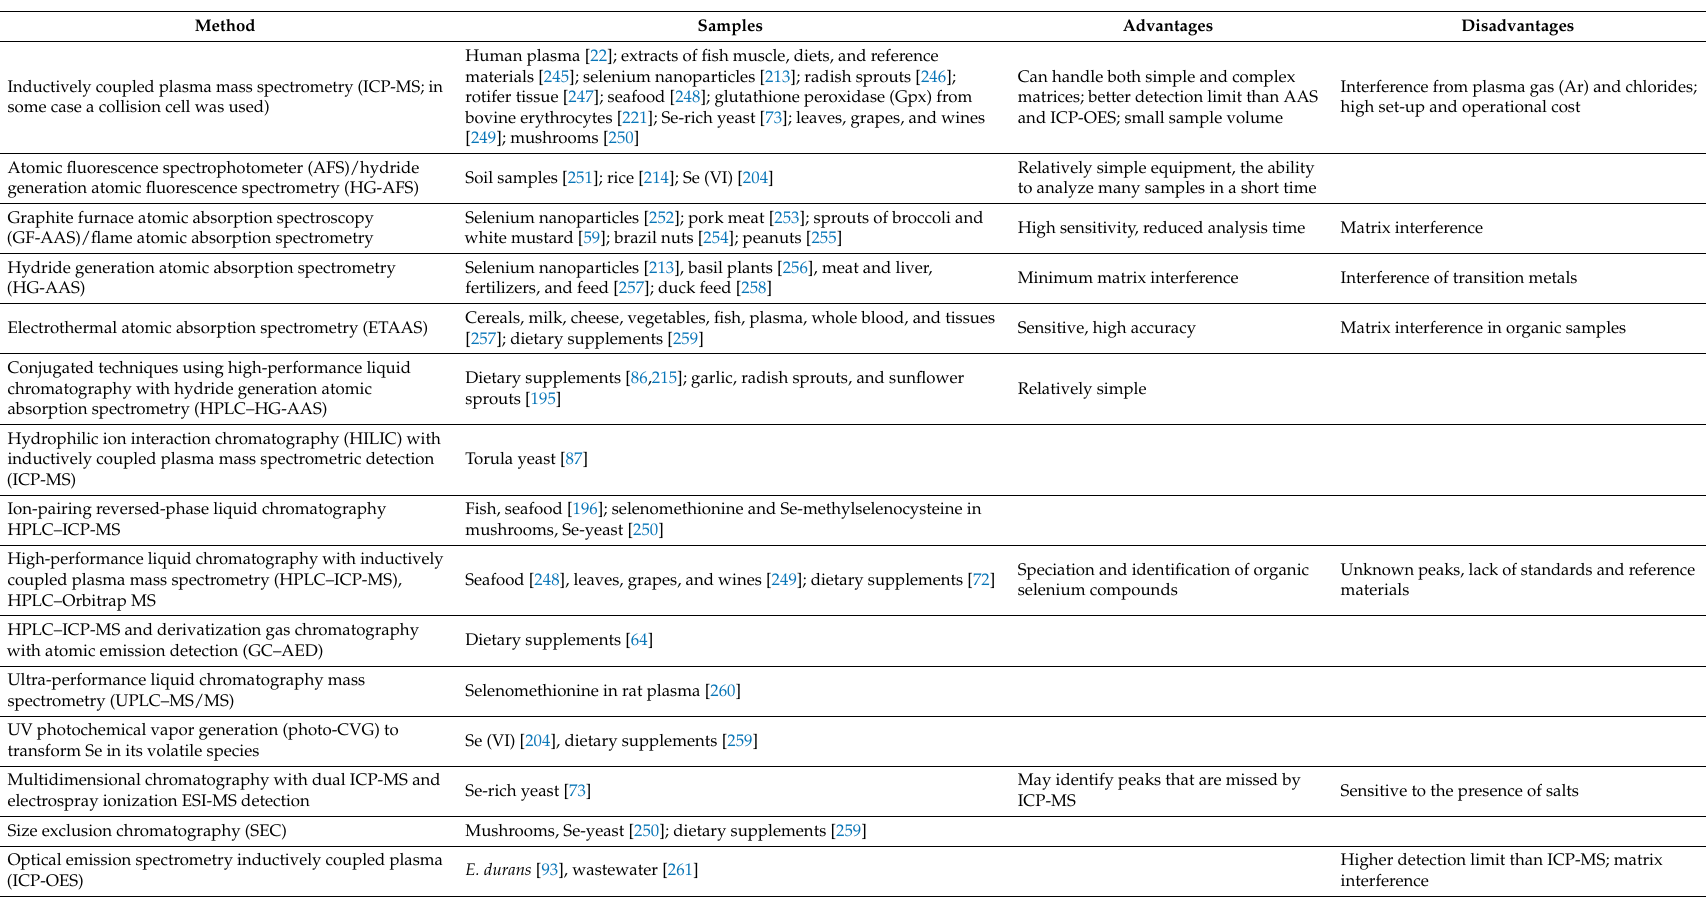
Table 2. Overview of selenium analysis and quantification